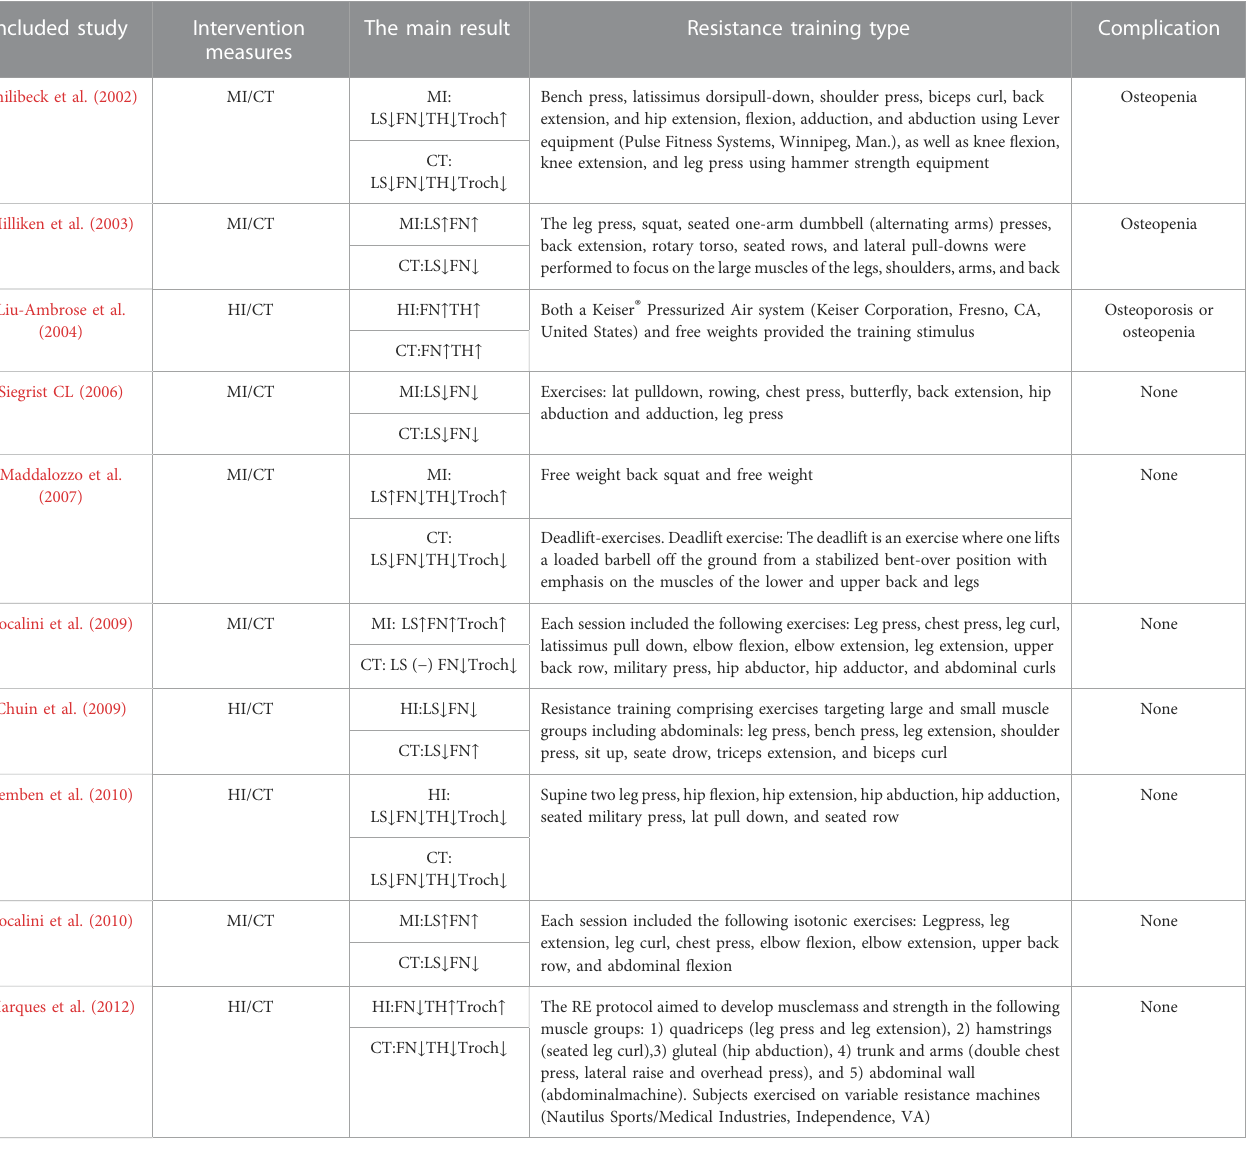
The leg press, squat, seated one-arm dumbbell (alternating arms) presses, back extension, rotary torso, seated rows, and lateral pull-downs were performedtofocusonthelargemusclesofthelegs,shoulders,arms,andback